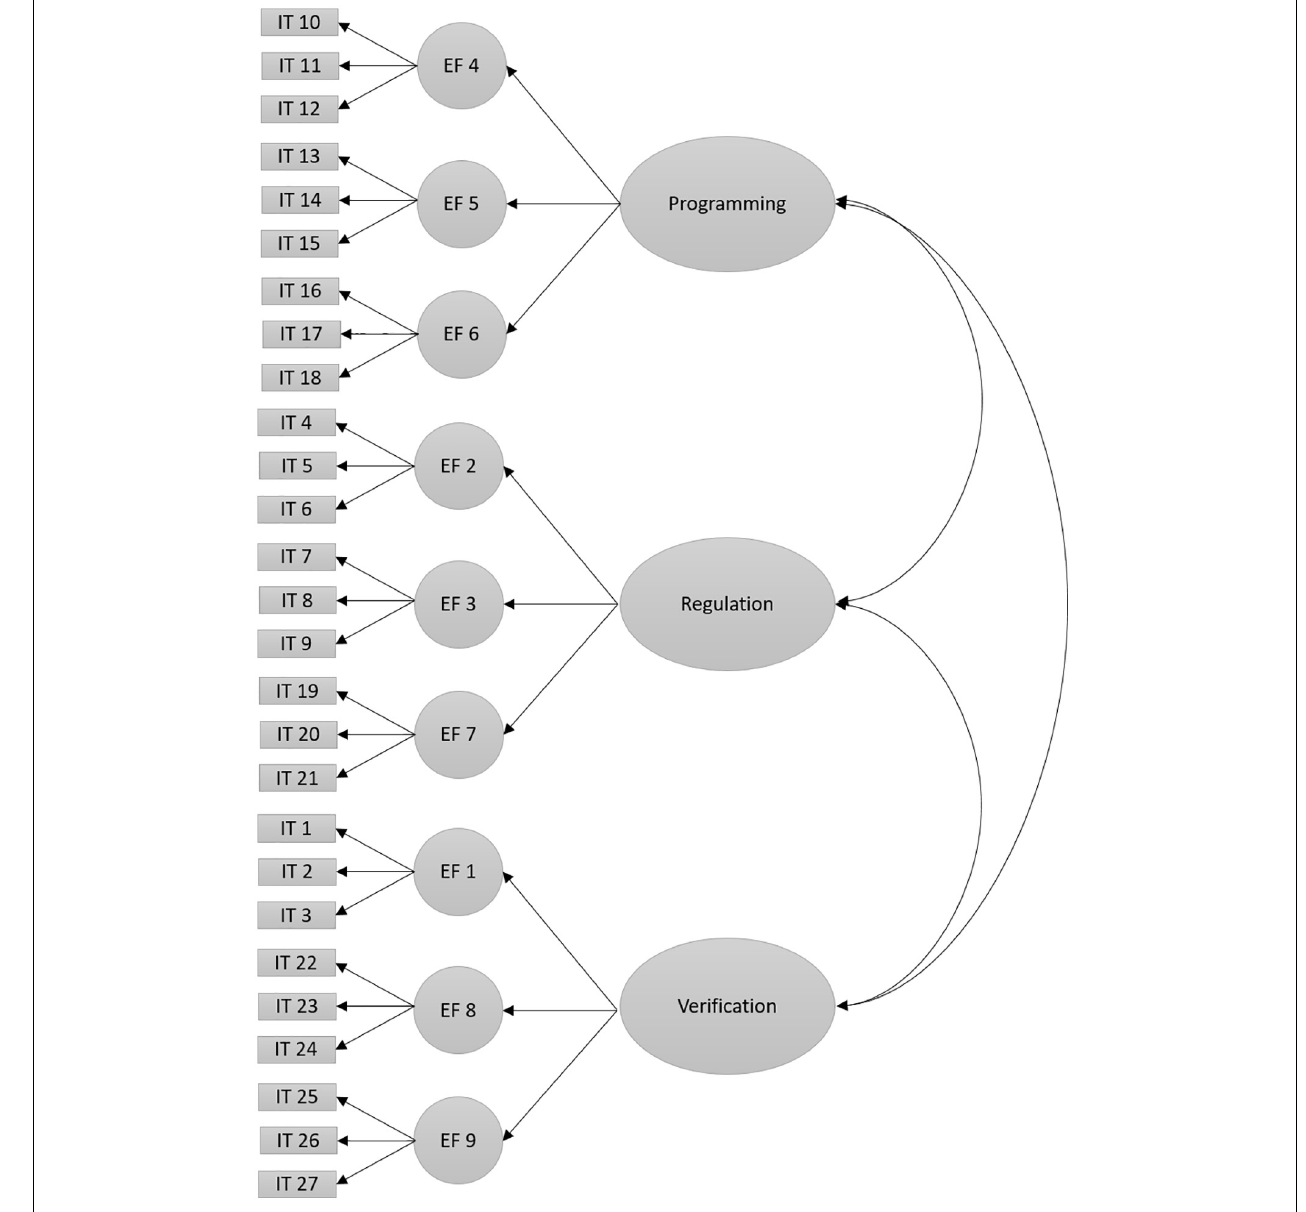
FIGURE 1 | Three-factor model of second order of the EOCL-1 scale (Model 1). Note. EF 1, error correction; EF 2, internal behavioral and cognition regulatory language; EF 3, limbic system conscious regulation; EF 4, decision making; EF 5, future consideration of the consequences of actions; EF 6, goal-directed behavior; EF 7, inhibitory control of automatic responses; EF 8, creation of new behavioral repertoires; EF 9, cognitive–behavioral activity